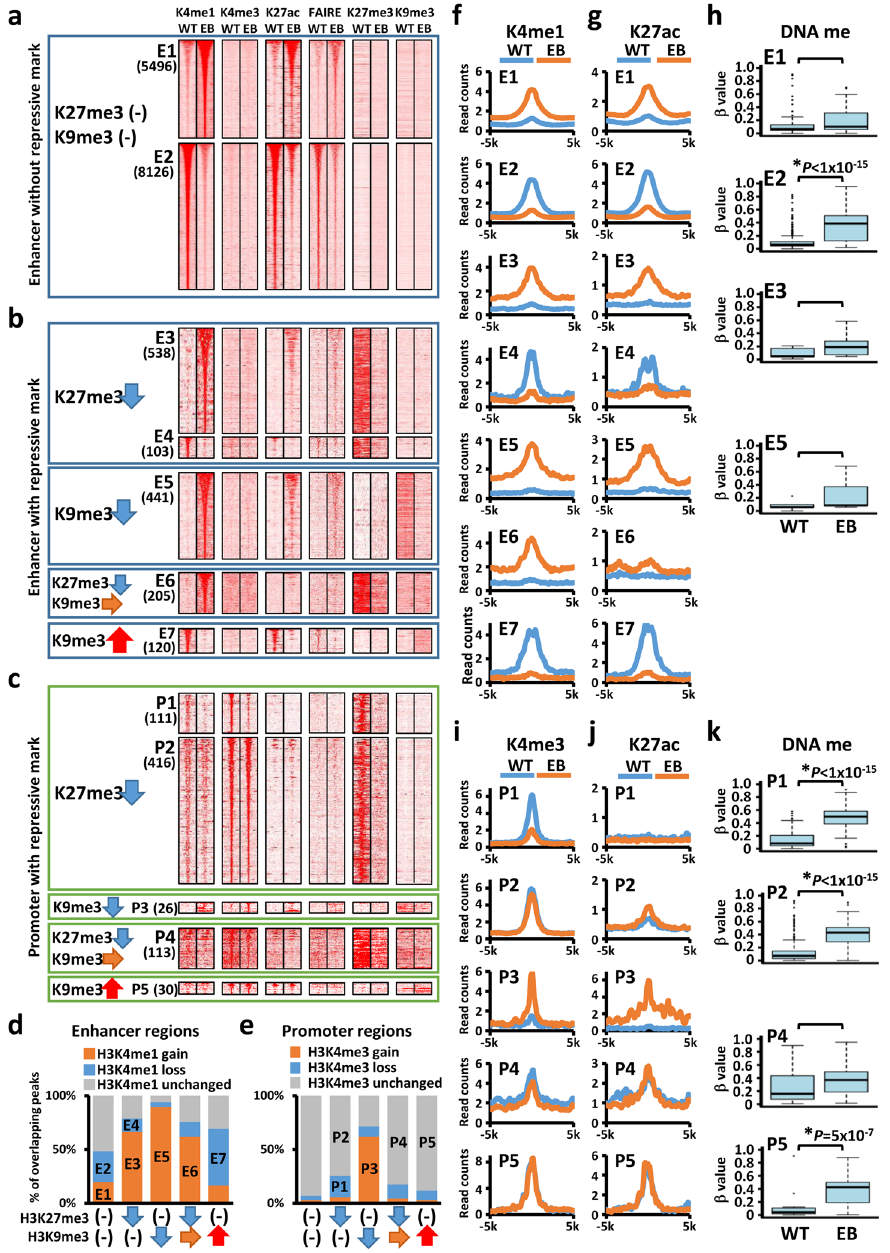
Figure 1. Global epigenetic alteration at enhancer and promoter regions. WT , MKN7 without EBV infection. EB , EBV-infected MKN7 cells. ( a , b ) Histone modification alteration at enhancer regions with or without repressive marks. Heatmaps represent read density of H3K4me1, H3K4me3, H3K27ac, FAIRE, H3K27me3, and H3K9me3 profiles in ± 5-kb regions centred on H3K4me1 peaks without H3K27me3 and H3K9me3 modifications ( a ), or with H3K27me3 or H3K9me3 alteration ( b ). H3K4me1 level was increased in subgroups E1, E3, E5, and E6, while H3K4me1 level was decreased in subgroups E2, E4, and E7. ( c ) Histone modification alteration at promoter regions with repressive marks. Read densities of H3K4me1, H3K4me3, H3K27ac, FAIRE, H3K27me3, and H3K9me3 in ± 5-kb regions are represented in heatmaps, centred on H3K4me3 peaks. H3K4me3 level was decreased in P1, and increased in P3, while H3K4me3 level was not changed in P2, P4, and P5. ( d ) Fractions of each enhancer subgroup in H3K4me1 gain, loss, or unchanged peaks. ( e ) Fractions of each promoter subgroup in H3K4me3 gain, loss, or unchanged regions. ( f ) Profiles of average H3K4me1 distribution at each enhancer subgroup. ( g ) Profiles of average H3K27ac distribution at each enhancer subgroup. ( h ) Average DNA methylation level at the centre of each enhancer. * Significant increase ( P < 0.05: paired t -test) of β value from < 0.2 to > 0.4. ( i ) Profiles of average H3K4me3 distribution at each promoter subgroup. ( j ) Profiles of average H3K27ac distribution at each promoter subgroup. ( k ) Average DNA methylation level at overlapping gene promoters. * Significant increase ( P < 0.05: paired t -test) of β value from < 0.2 to >